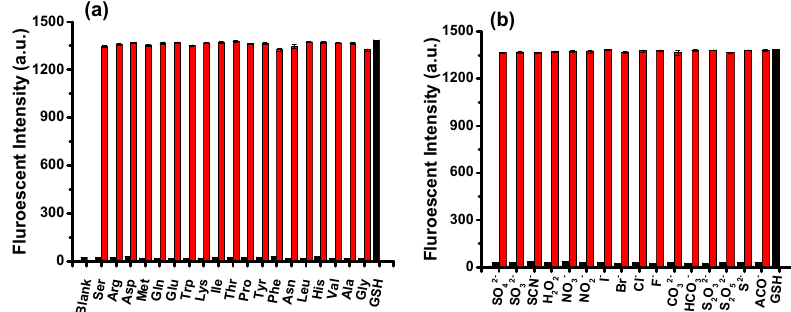
Figure 4. ( a , b ) Selectivity and competition of PBD (10 µ M) to GSH (100 µ M) and other analytes (200 µ M). Black bars represent the fluorescence intensity (540 nm) of a single analyte with probe PBD . Red bars represent the fluorescence intensity (540 nm) of PBD to GSH in the presence of various tested analytes. λ ex = 405 nm.